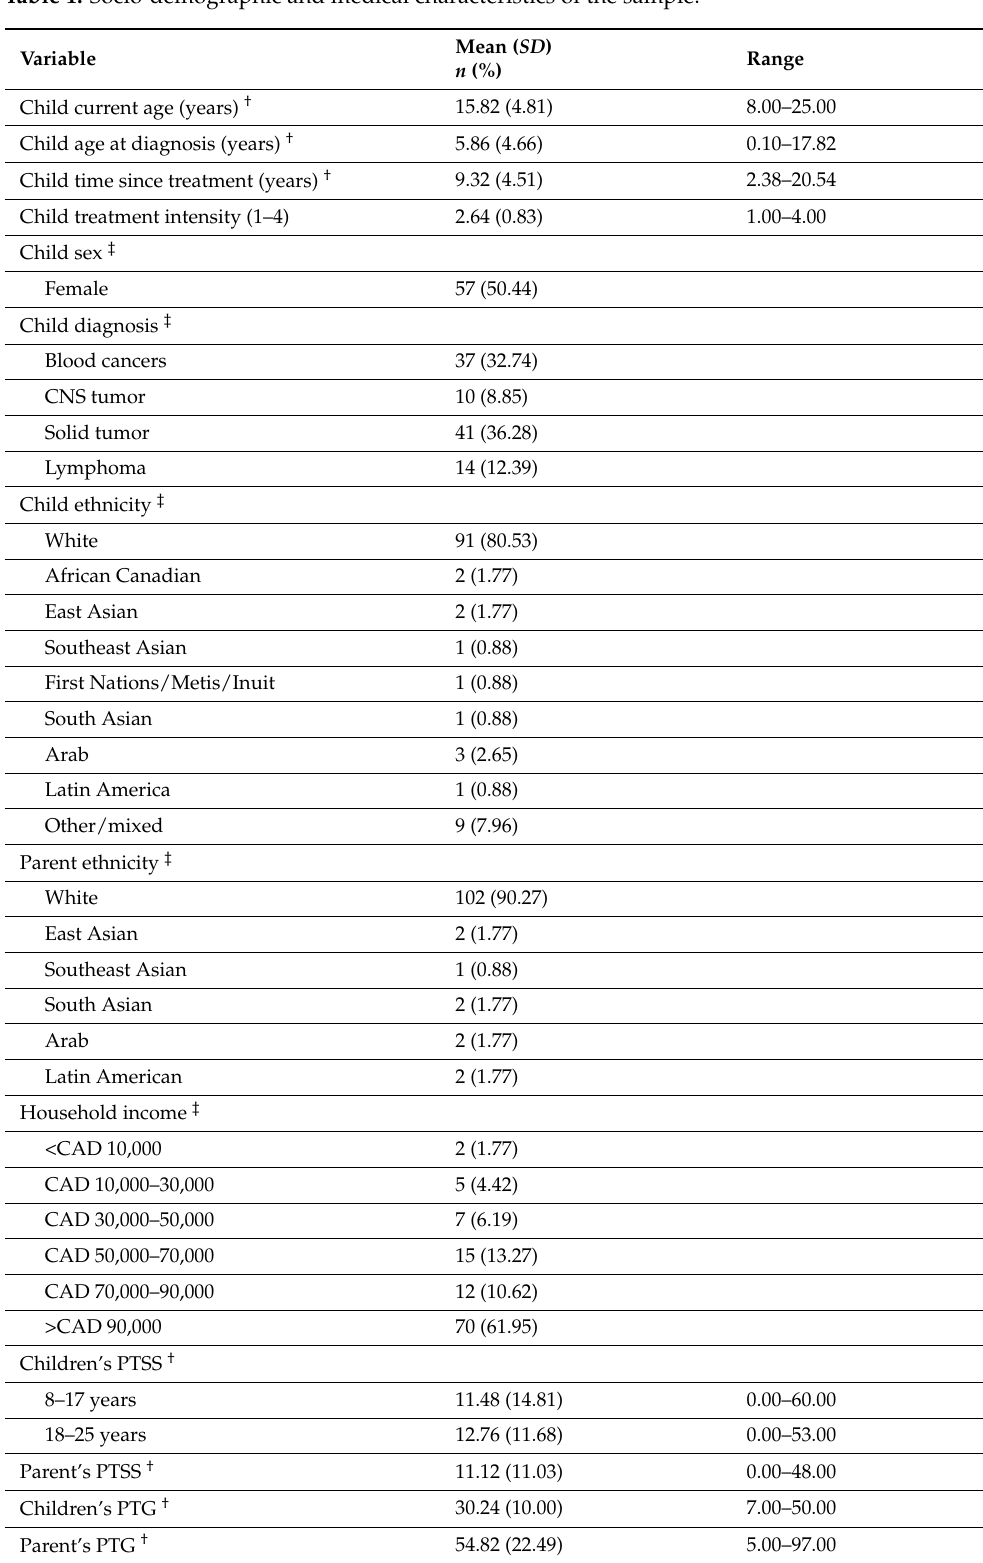
Table 1. Socio-demographic and medical characteristics of the